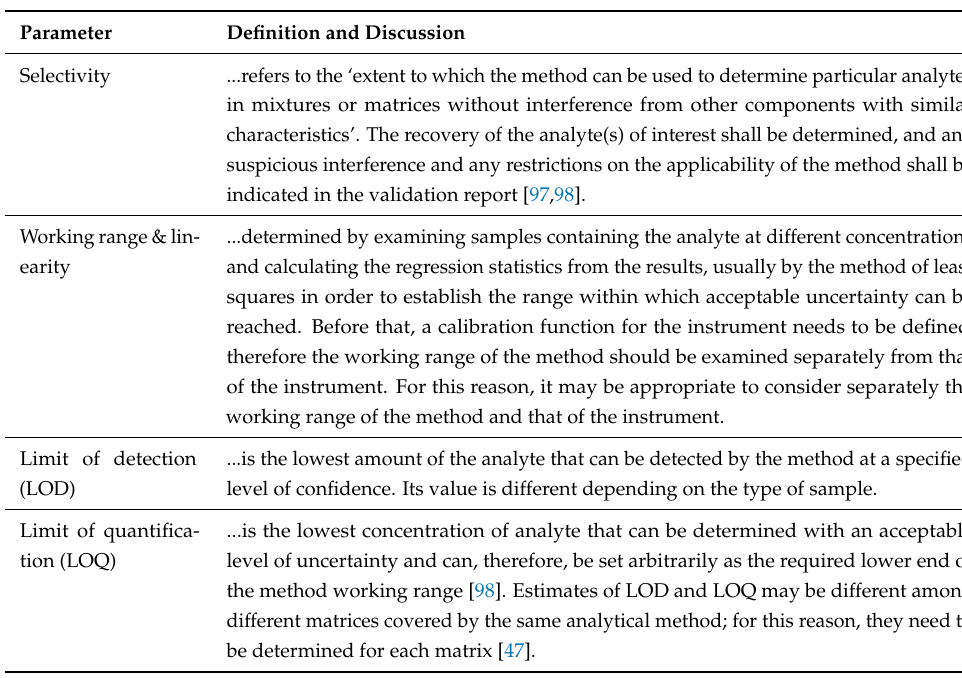
Table 2. Performance parameters for the validation of analytical